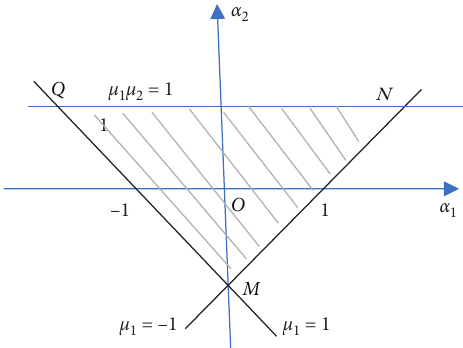
Figure 4: Choice of regulator pole area (triangle region MNQ